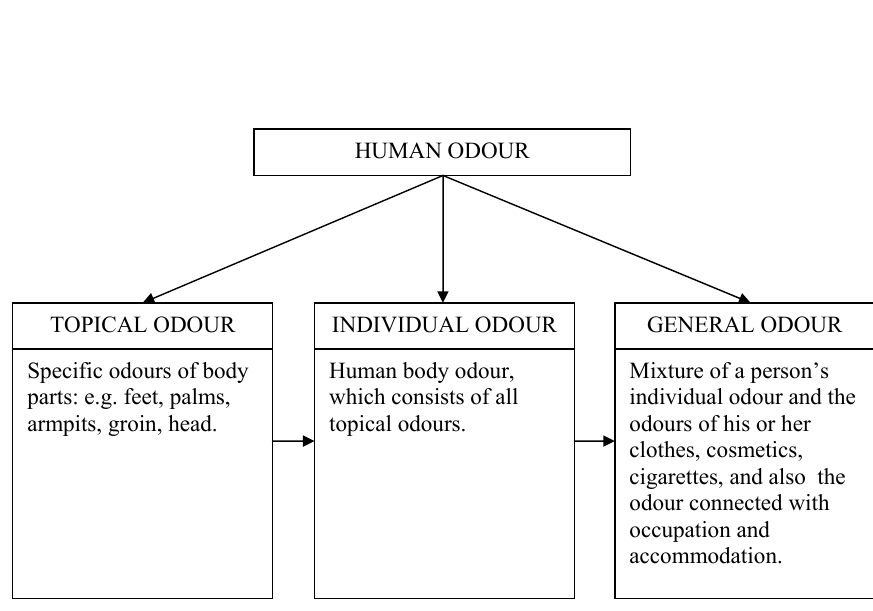
Fig. 3. The structure of human odour by A. Winberg, source: (cid:224)achacz 1998, p.